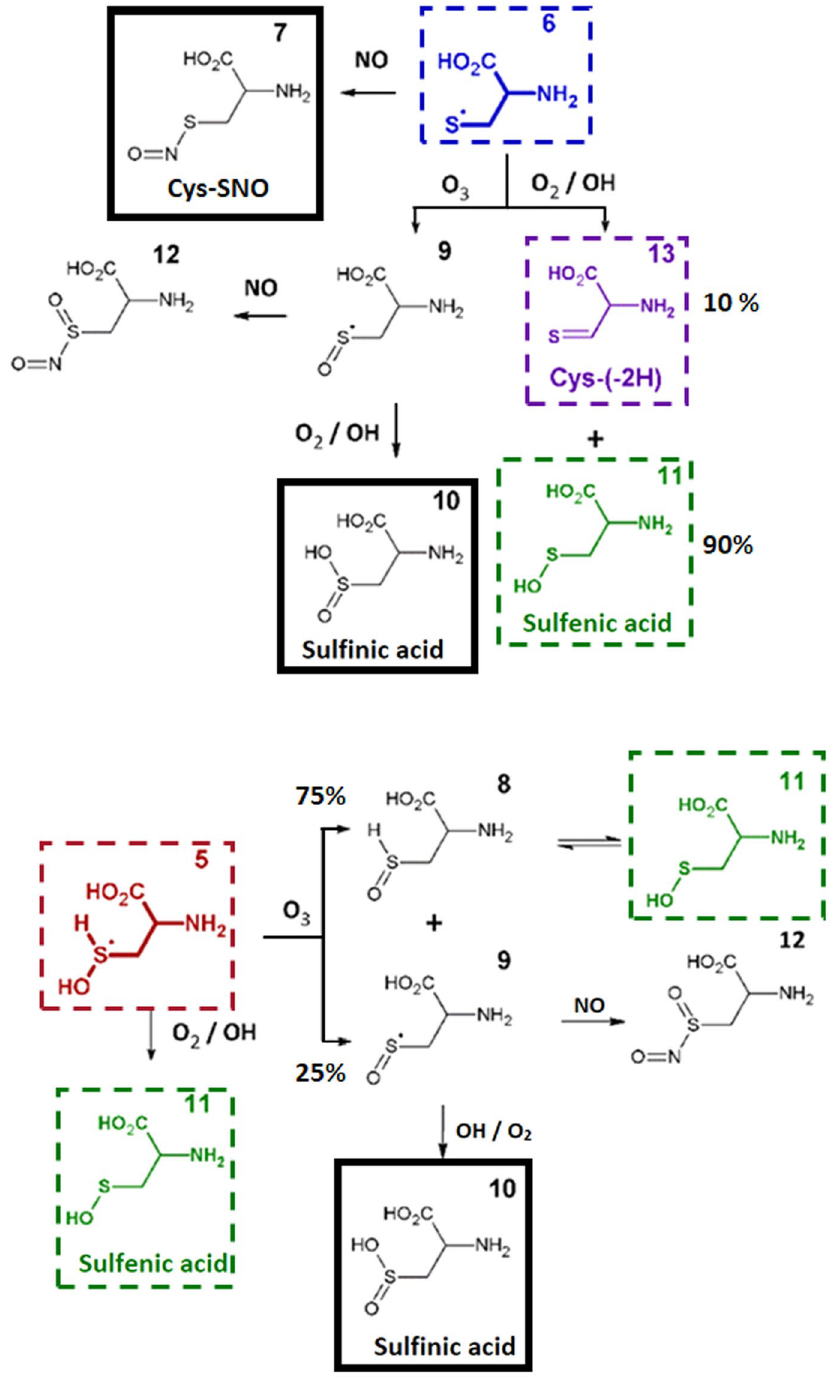
Figure 6. Summary of the predicted reaction paths encountered during the further oxidation of Cys-(-H) (6; top) and Cys-SOH 2 (5; bottom). Important oxidation products are indicated using a solid black box. Important intermediates are marked with dashed coloured boxes. Branching ratios (compared to the total number of observed reactions) are depicted in cases when multiple reactions products were observed during the